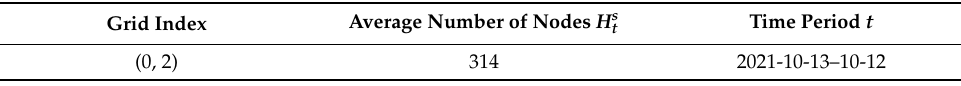
Table 6. Average number of nodes of Grid s in period t .